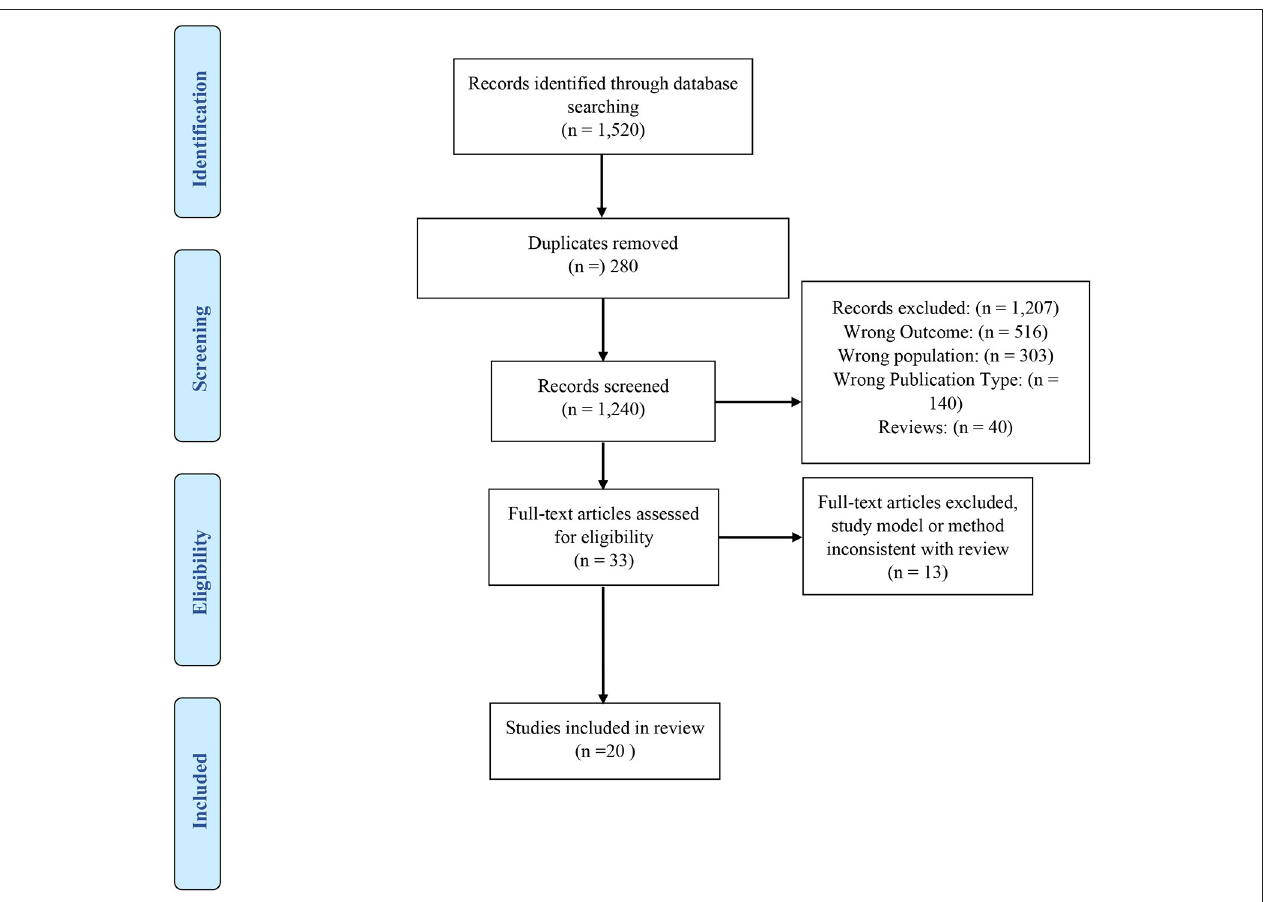
FIGURE 1 | PRISMA flow diagram of results and publication